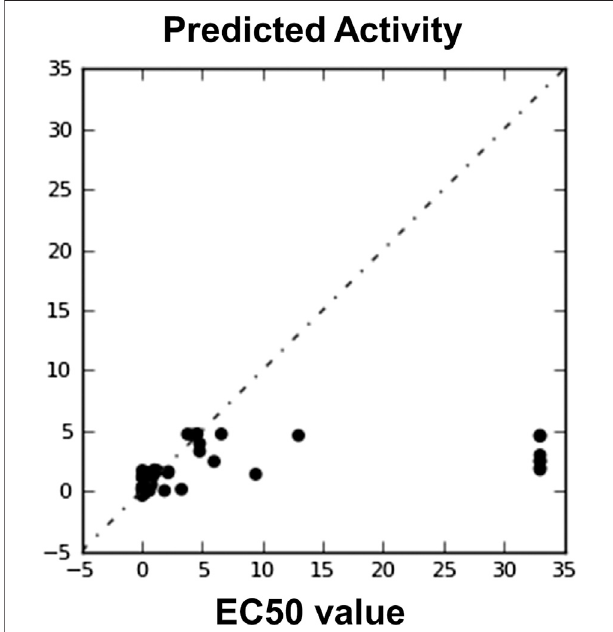
FIGURE 6 | Automatically generated regression plot of 3D QSAR EC50 value and phase predicted activity, where the X -axis signi fi es the EC50 score and Y -axis denotes the phase predicted activity of the chemical structure.